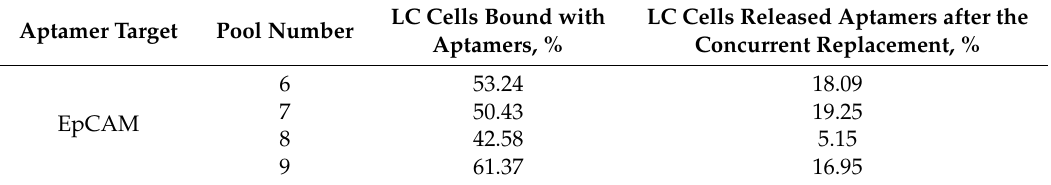
Figure 2. Binding evaluation of aptamer pools. Flow cytometry of lung cancer (LC) cells incubated with pools of 6–9th rounds of aptamer selection against EpCAM at the first step and displaced by EpCAM antibodies at the second step in comparison with LC cells alone. Table 2. A comparison of the percentage of LC cells bound with fluorescently labeled aptamers against the percentage of the same cells after aptamer replacement by antibodies as estimated by flow cytometry.